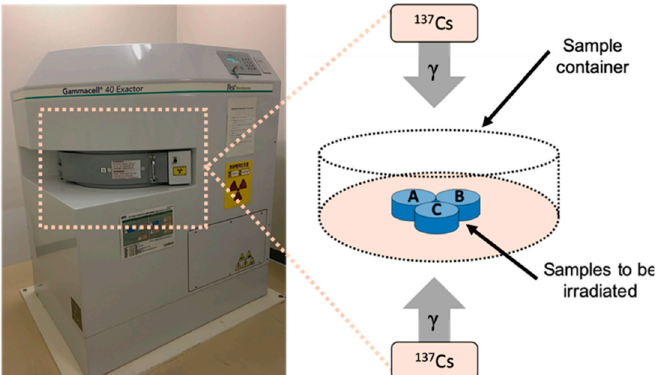
Figure 2. Experimental setup for the irradiation of the fingernail samples with the γ -ray irradiator ( left ) and the geometry of irradiated samples placed in between two 137 Cs γ -ray sources ( right